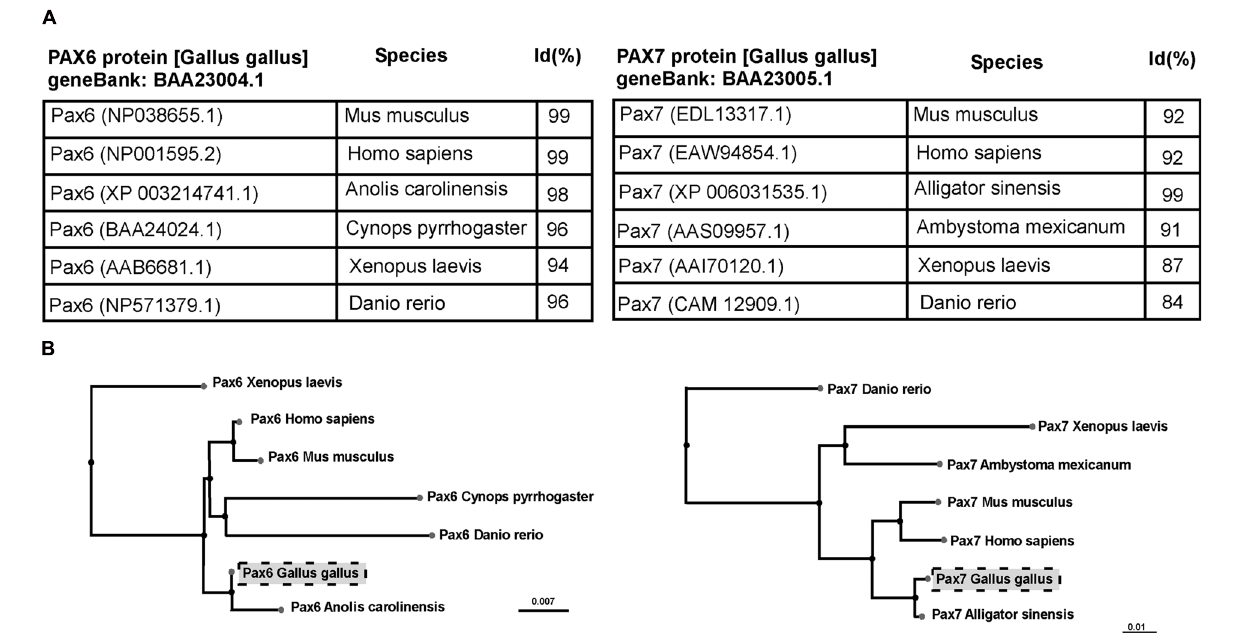
between a query and the database sequences searched. Thus, this tool allows to analyze multiple alignments and obtain a sequence tree presentation based on the alignment of database sequences to the